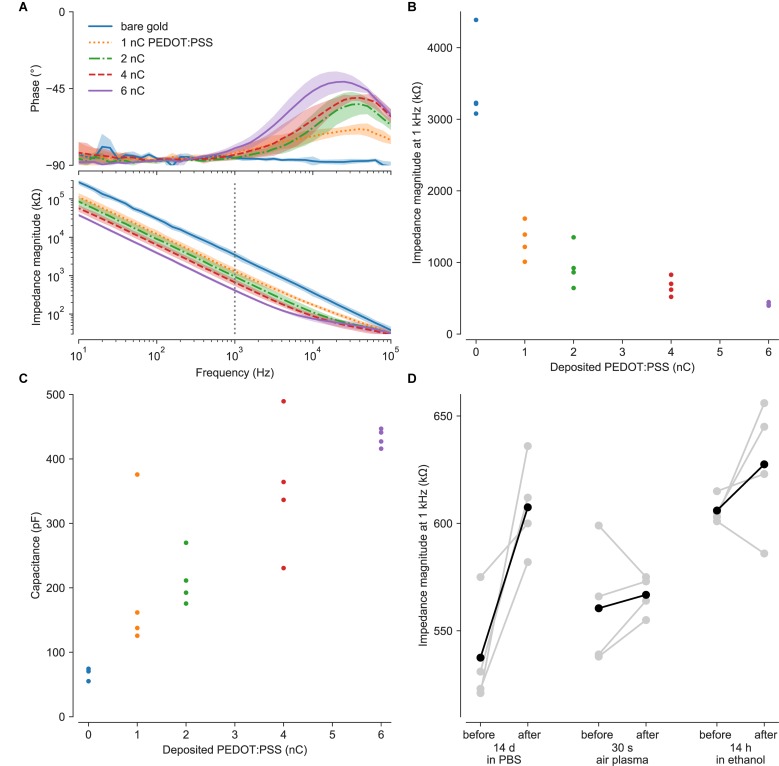
Electrochemical characterization. (A) Coating with PEDOT:PSS decreased the electrochemical impedance. Measurements of impedance of bare gold ultramicroelectrodes were compromised by the shunt capacitance of the insulator. (B) Increasing PEDOT:PSS deposition reduced impedance at the key frequency of 1 kHz. (C) Equivalent capacitances were fitted over the frequency range most relevant for extracellular electrophysiology (1–5000 Hz), where the electrodes had predominantly capacitive behavior with phase near −90°. (D) PEDOT:PSS coatings survived soaking in PBS at 37°C, exposure to air plasma, and ethanol disinfection. Degradation or removal of PEDOT:PSS would have reverted the electrodes to the value of several MΩ impedances (at 1 kHz) of the uncoated electrodes. Points in B and C indicate values from individual electrodes. Gray points in D indicate paired measurements for single electrodes; black points are averages as a visual guide.